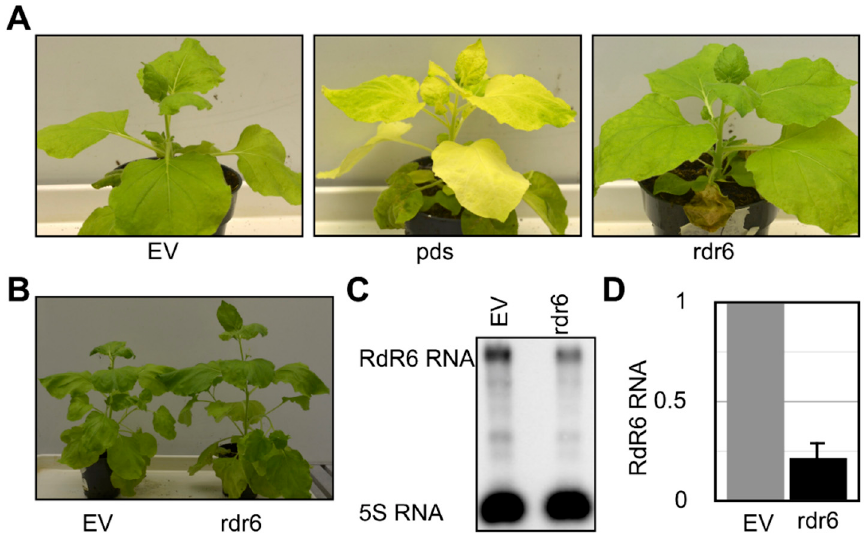
Figure 1. The knock-down of RdR6 in N. benthamiana resulted in a taller phenotype. N. benthamiana plants were subjected to a knock-down assay using a virus-induced gene silencing (VIGS) technique in order to verify the role of the RdR6 mRNA in determining the plant’s phenotype. ( A ) At 18 days post-agroinfiltration (dpa), the plants exhibited phenotypic alterations. ( B ) At 28-dpa the plants exhibited noticeable differences in their heights. Total RNA extracted from systemic leaf samples from the agroinfiltrated plants was subjected to ( C ) an RNA gel blot and ( D ) an RT-qPCR assay in order to evaluate the down-regulation of RdR6 in N. benthamiana plants. The expression change is presented on a log2 scale. EV, plants agroinfiltrated with pTRV2-EV vector; pds, plants agroinfiltrated with pTRV2:PDS vector; rdr6, plants agroinfiltrated with pTRV2-RdR6 vector. Each experiment was performed at least three times with true biological replicates.